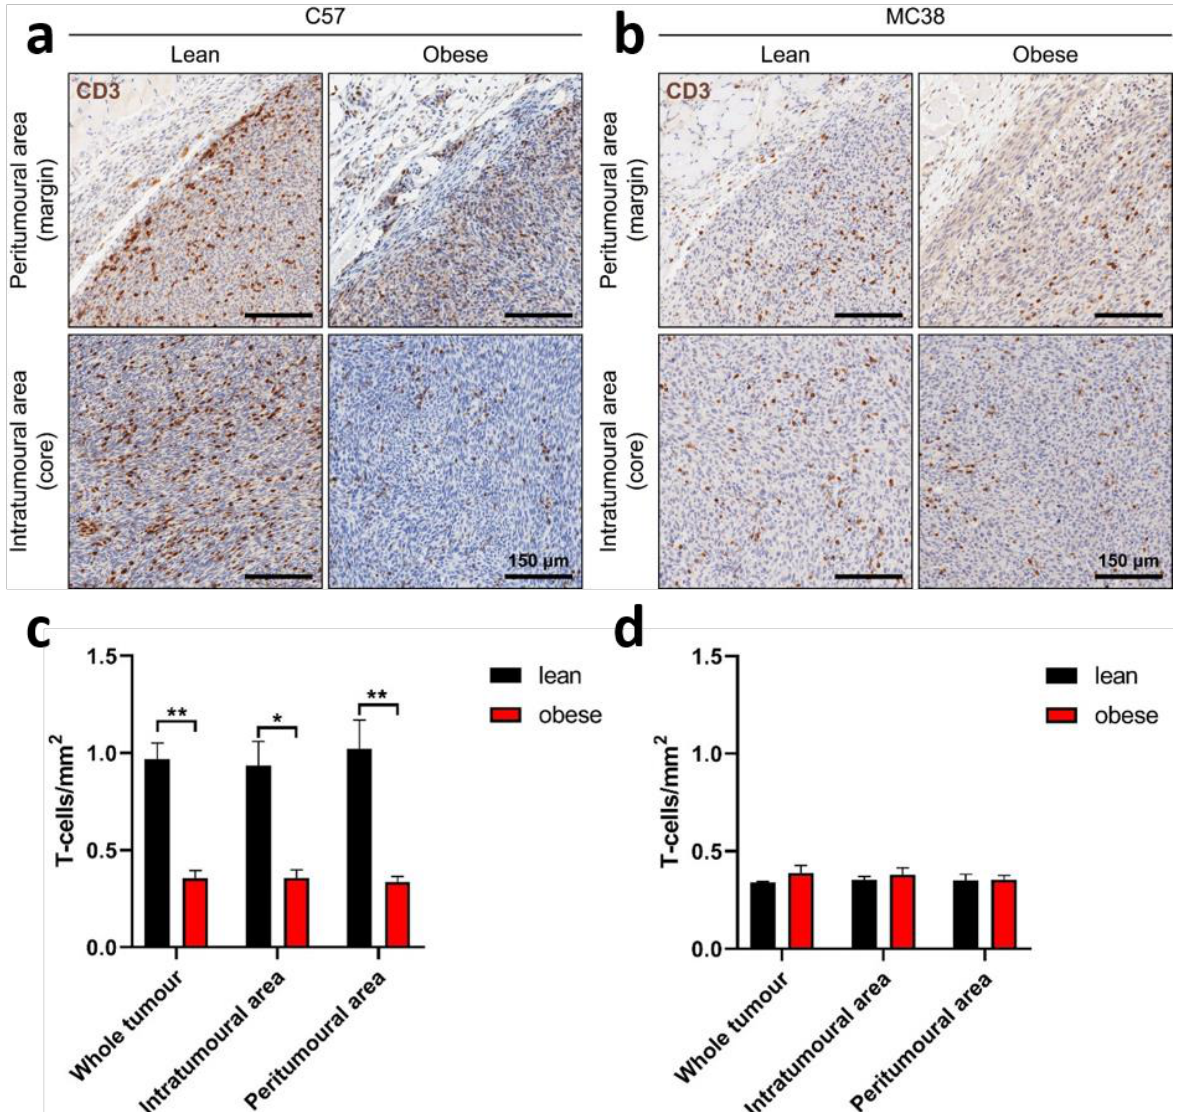
Figure 5. TIL frequencies in BC and CRC tumours. Tumours from ( a , c ) C57mg and ( b , d ) MC38 cells were extracted at 150 mm 2 , preserved by FFPE, sectioned for immunohistochemistry and stained with CD3. Images ( a , b ) show immunohistochemical staining for CD3 (DAB, brown) with a haematoxylin stain (blue) for the peritumoural (top row) and intratumoural (bottom row) CD3 + regions of C57mg and MC38 tumours. Results show the mean + STD of 5 mice/group. Statistical differences were determined by using an unpaired student’s t -test. * p < 0.05, ** p < 0.01.